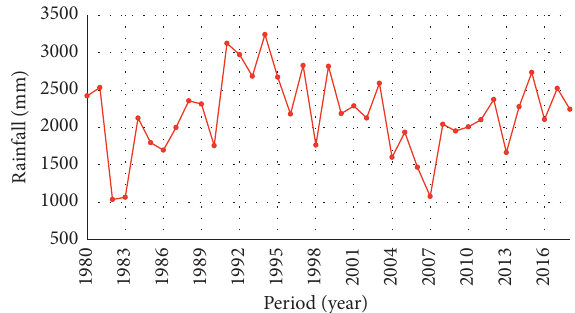
Figure 2: Time series plot of the precipitation trends for state of Selangor,